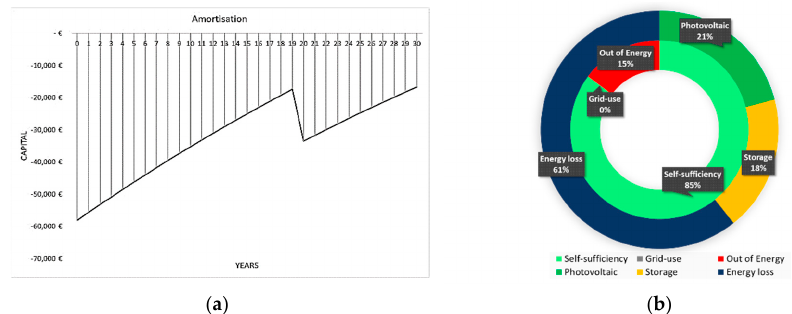
Figure 20. Off-grid, 20 kWh battery storage, 21 kWp, 34 km daily driven distances: ( a ) lifetime payback graph, ( b ) energy balance.